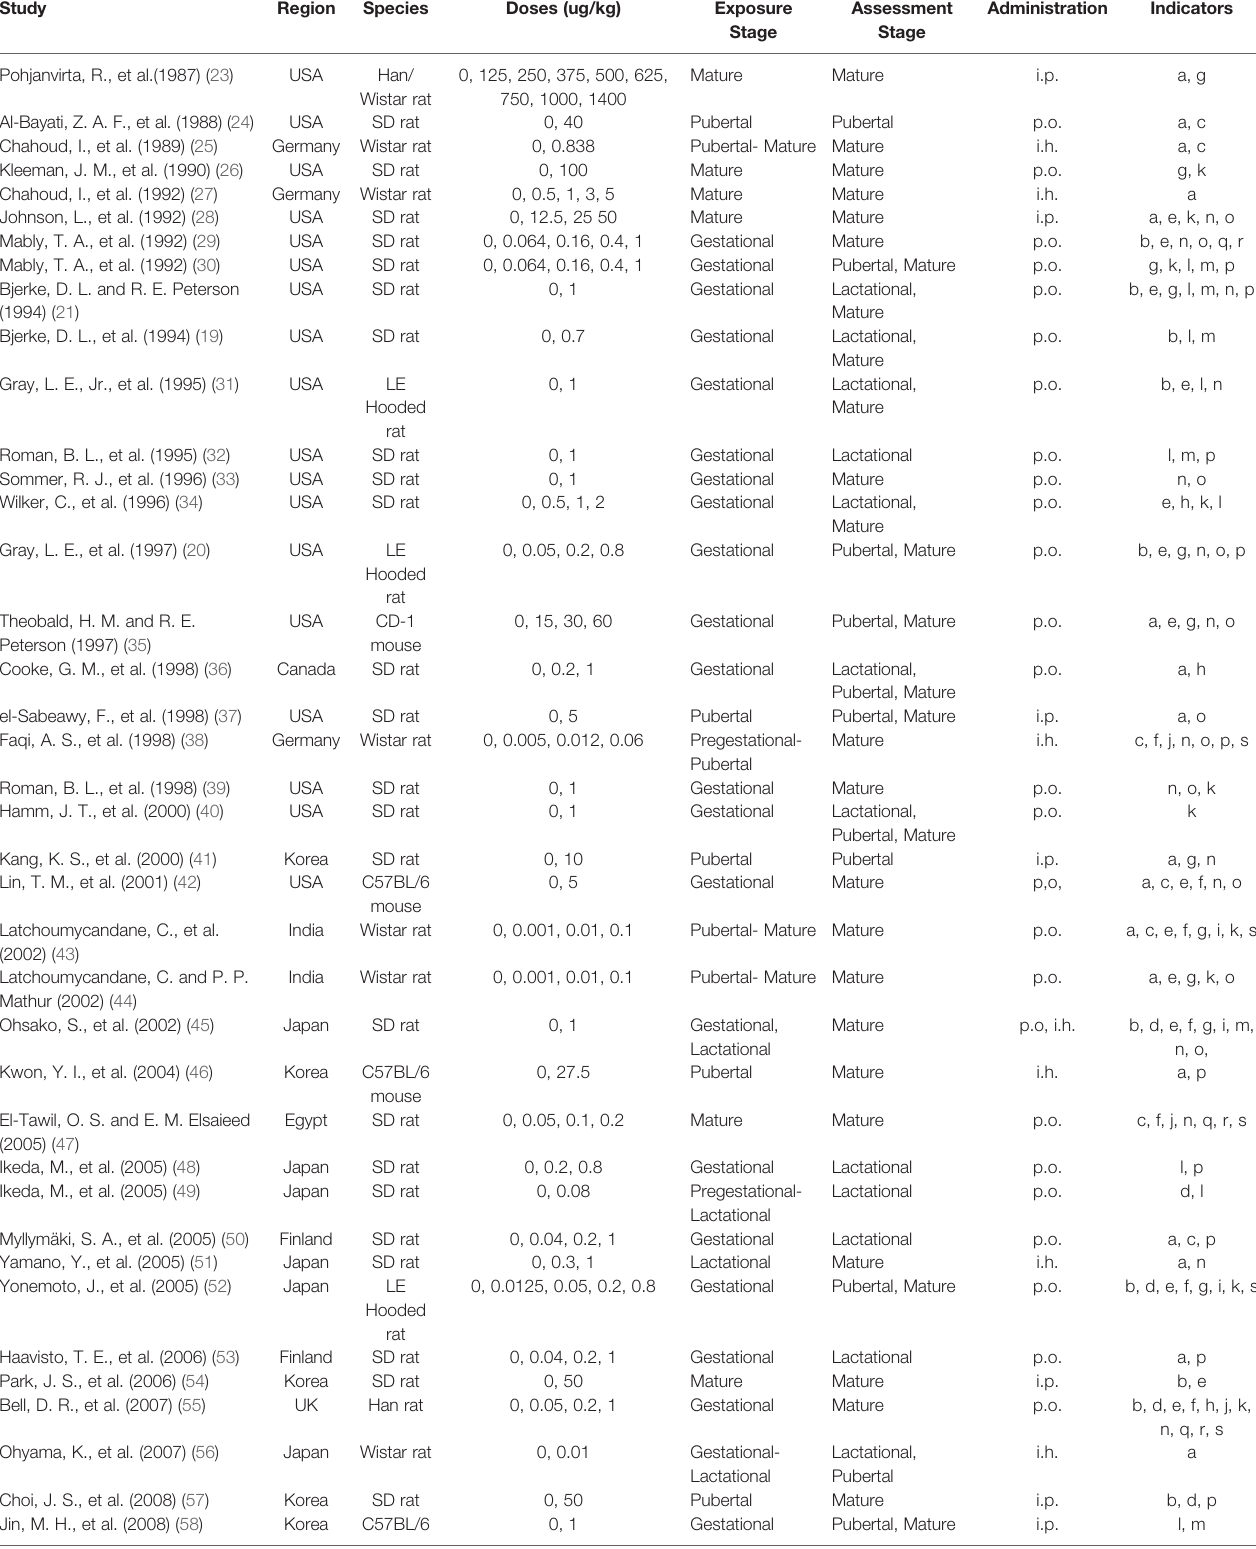
TABLE 1 | General characteristics of the included